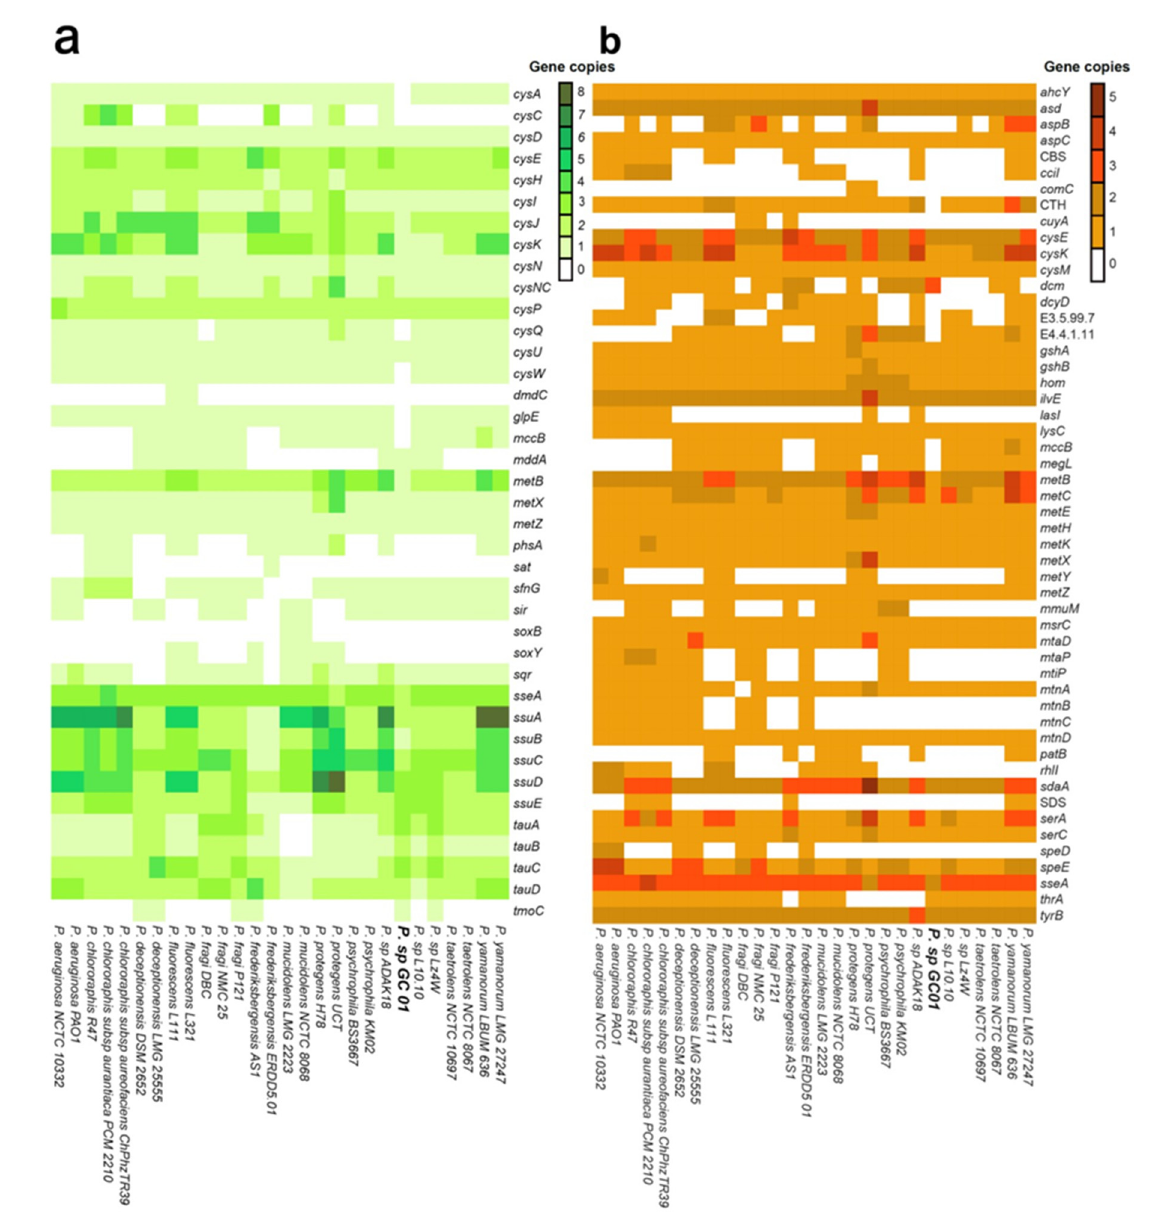
Figure 6. Heatmap of the sulfur metabolic genes present in the 28 Pseudomonas genomes analyzed. ( a ) Sulfur metabolism genes. ( b ) Cysteine and methionine metabolism genes. The heat scale shows the copy number of each gene in the corre- sponding genome.